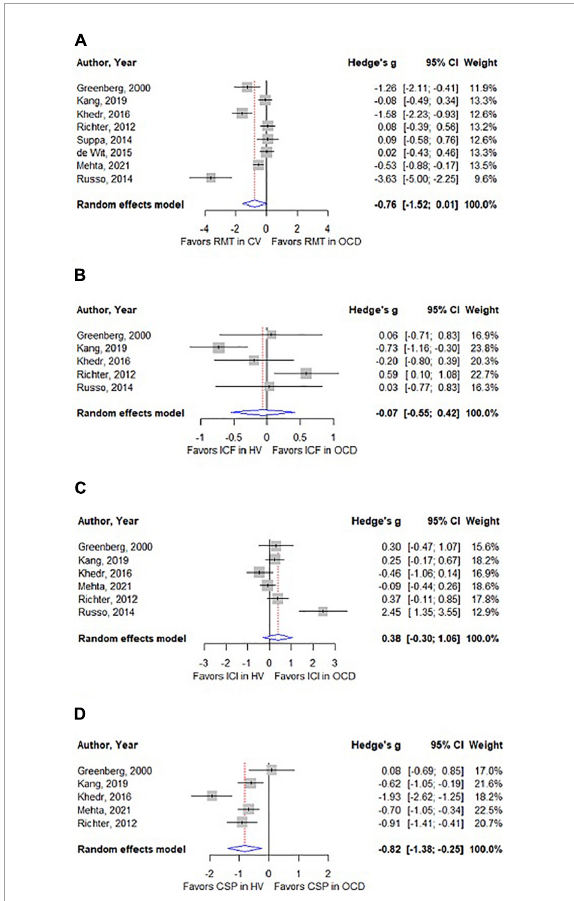
FIGURE2 (A) Forest plot comparing resting motor threshold (RMT) between patients with OCD and control volunteers. (B) Forest plot comparing intracortical facilitation (ICF) between patients with OCD and control volunteers. (C) Forest plot comparing short intracortical inhibition (SICI) between patients with OCD and control volunteers. (D) Forest plot comparing cortical silent period (CSP) between patients with OCD and control volunteers.